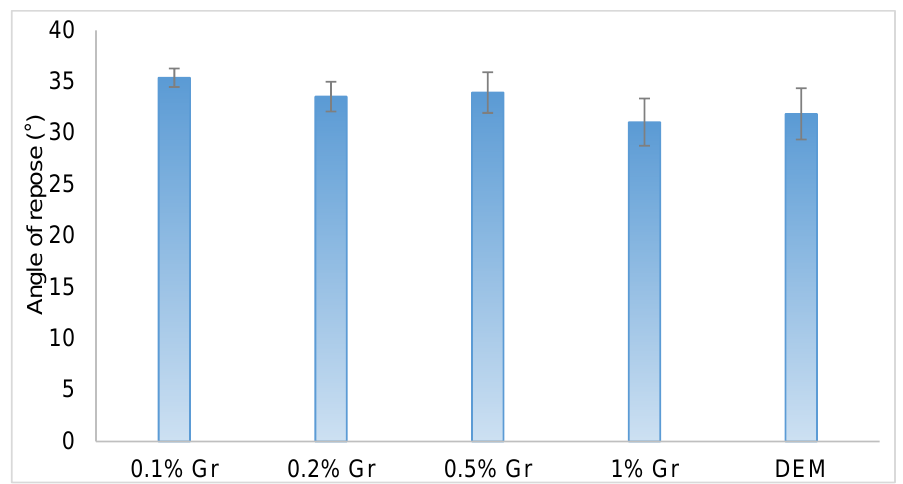
Figure 19. The hillside angles of 4 h milled powders with different percentages of Gr (0.1, 0.2, 0.5, and 1 wt.%) and DEM.